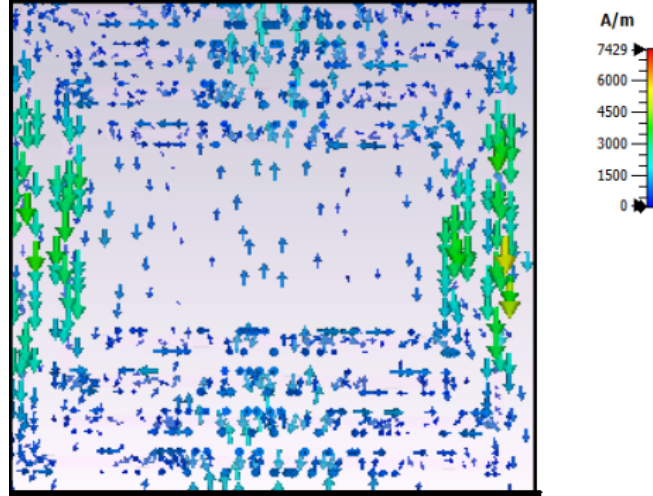
Figure 14. Current distribution plot at 3.045